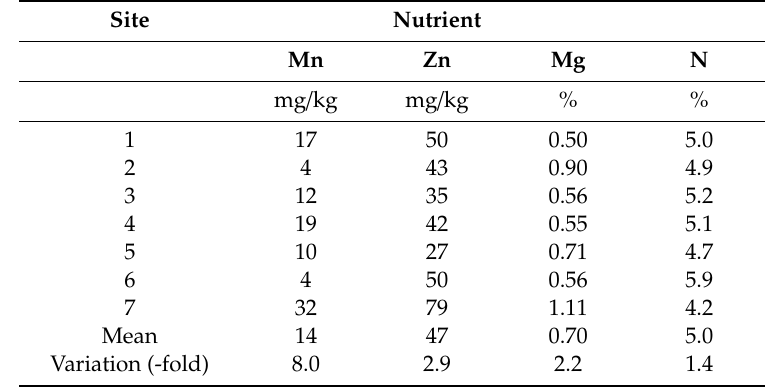
Table 3. Variation in selected minerals in leaves of Cnidoscolus aconitifolius (chaya) growing at seven locations in Tuvalu (sites 1 and 2) and Kiribati (sites 3–7) from 2014 to 2017. This study illustrates variation due mostly to di ff erences in plant-available levels of these nutrients in soil. Most minerals (Zn, Mg, N) varied by less than